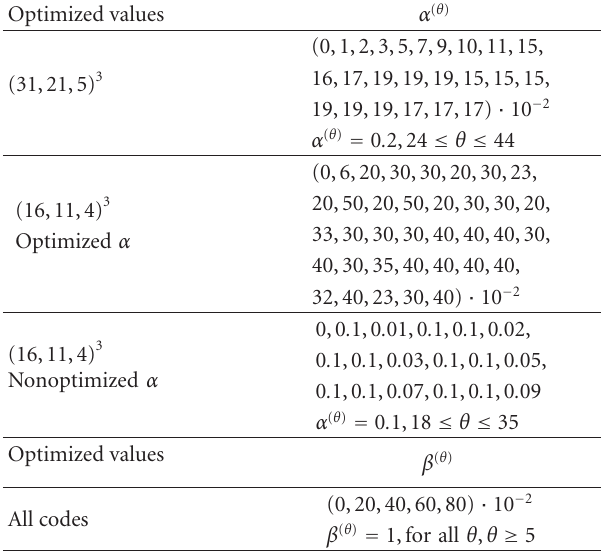
Table 2: Optimized values of α and β for IGAD1.